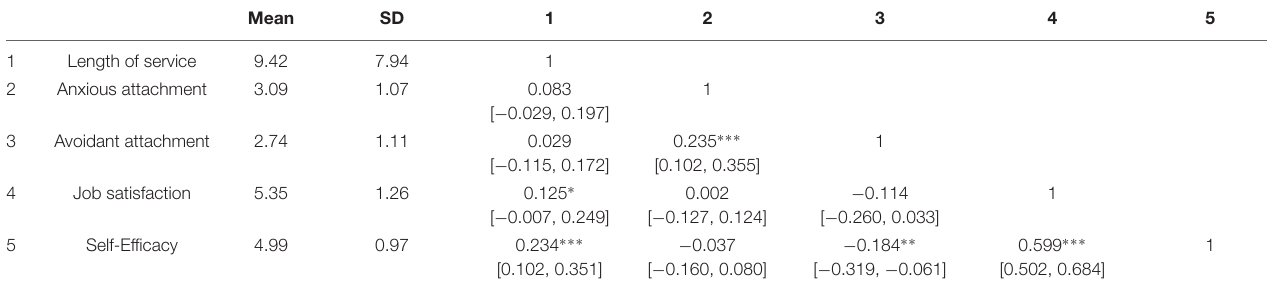
TABLE 1 | Descriptive statistics and intercorrelations ( N = 268).